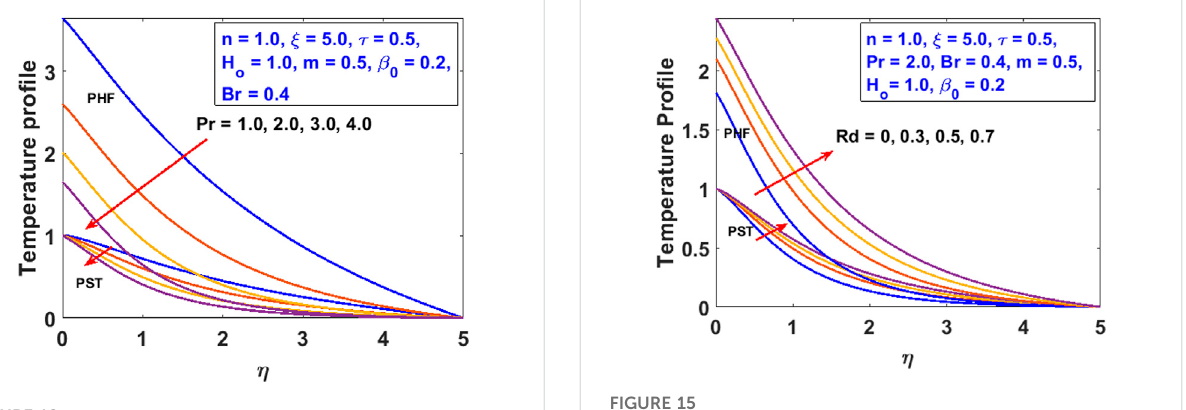
FIGURE 12 Effects of Pr on temperature.